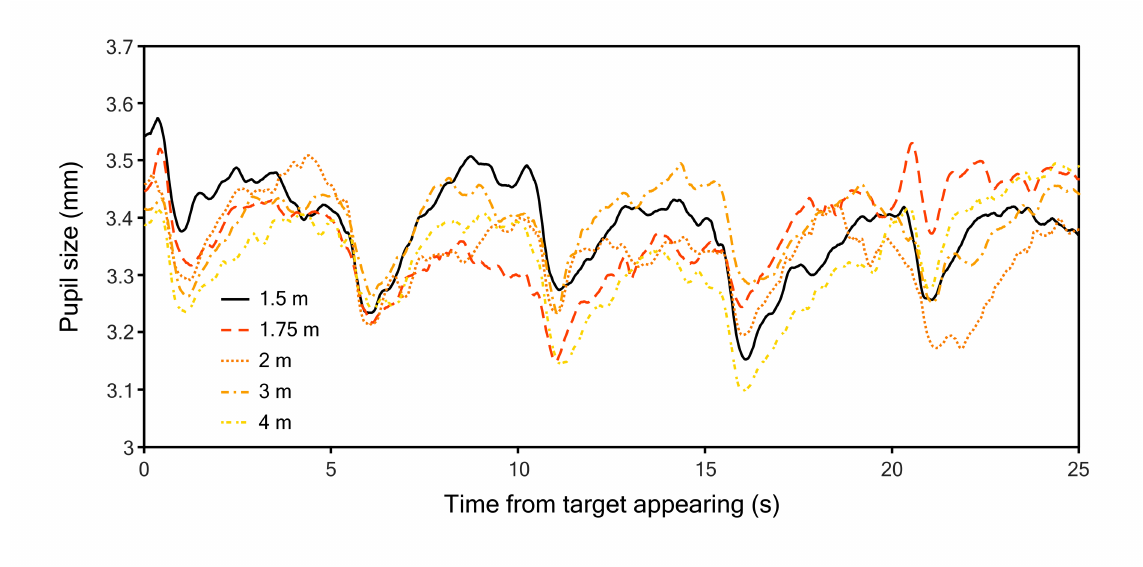
Figure 5. Full 25 second pupil traces of experiment 2. The target first appeared at 0 s. Every five second the target jumped to the next